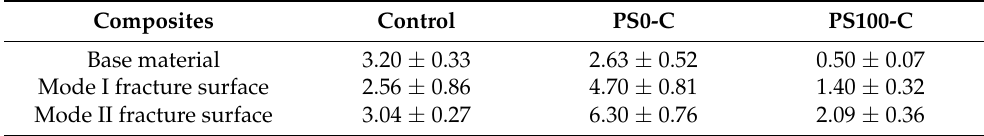
Table 3. The AO erosion rate of the composites ( × 10 − 24 cm 3 /atom).